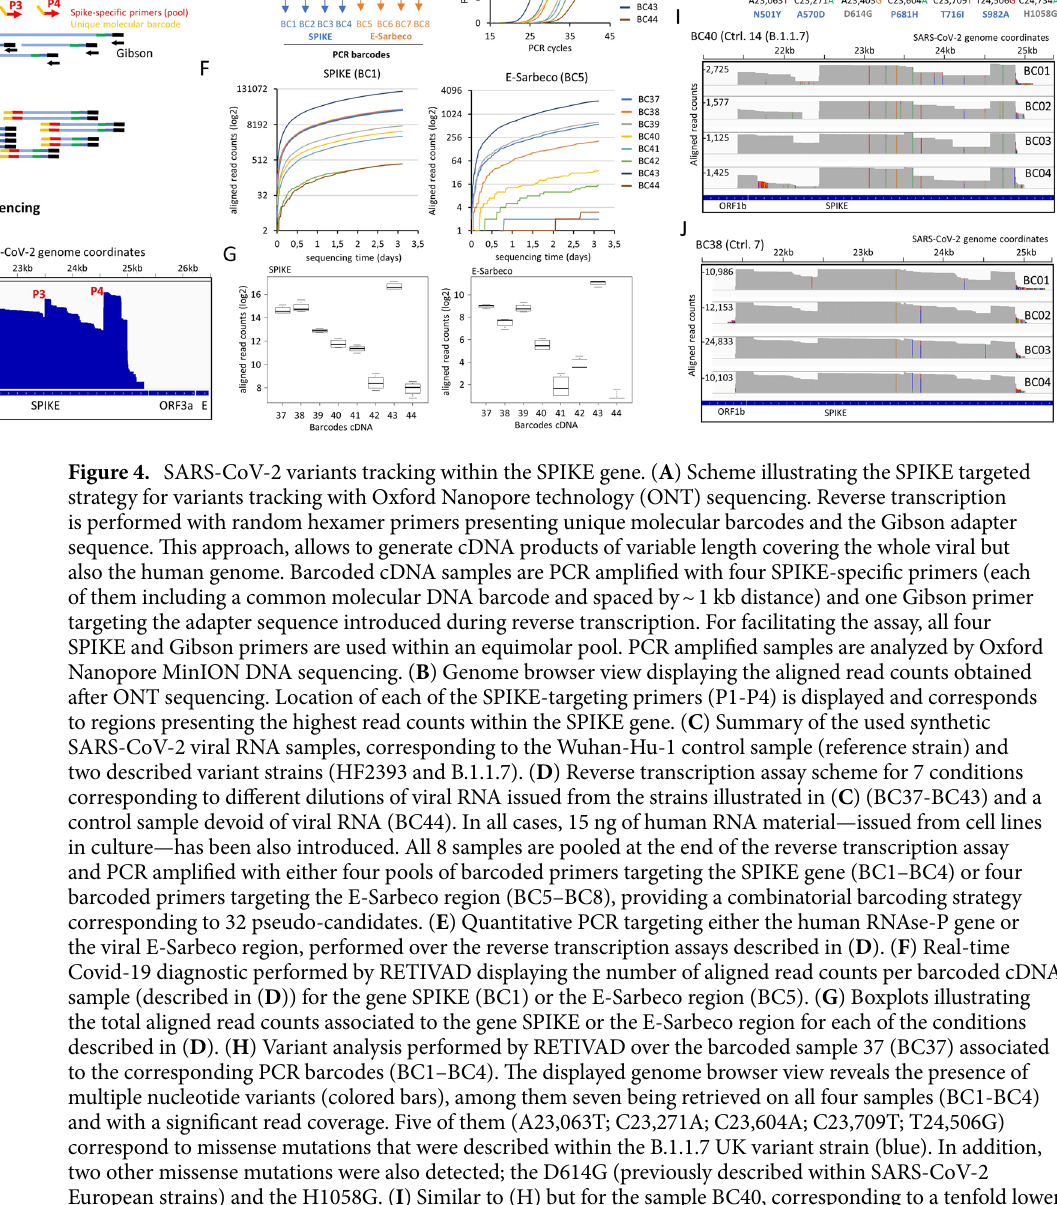
them, five correspond to those previously described within the strain B.1.1.7 (N501Y, A570D, P681H, T716I and S982A); coherent with the fact that samples associated to the BC37 were generated with the synthetic viral